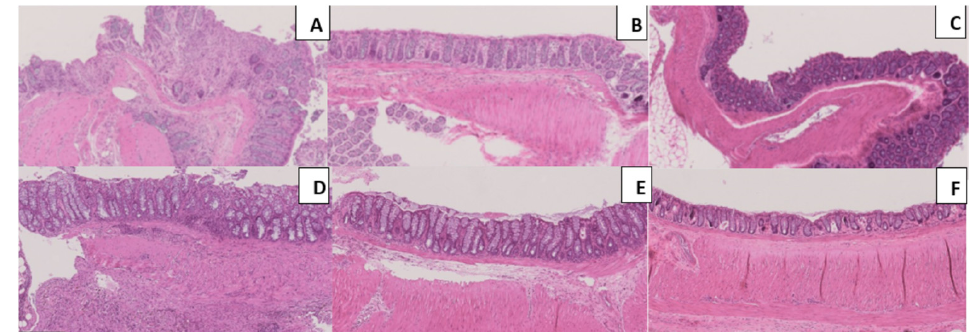
Figure 7. Histopathological analyses of Masson’s trichrome staining 10×. Legend: ( A ) TNBS group; ( B ) ethanol group; ( C ) sham group; ( D ) TNBS + TOP10 group; ( E ) TNBS + TOP20 group; ( F ) TOP20 group.